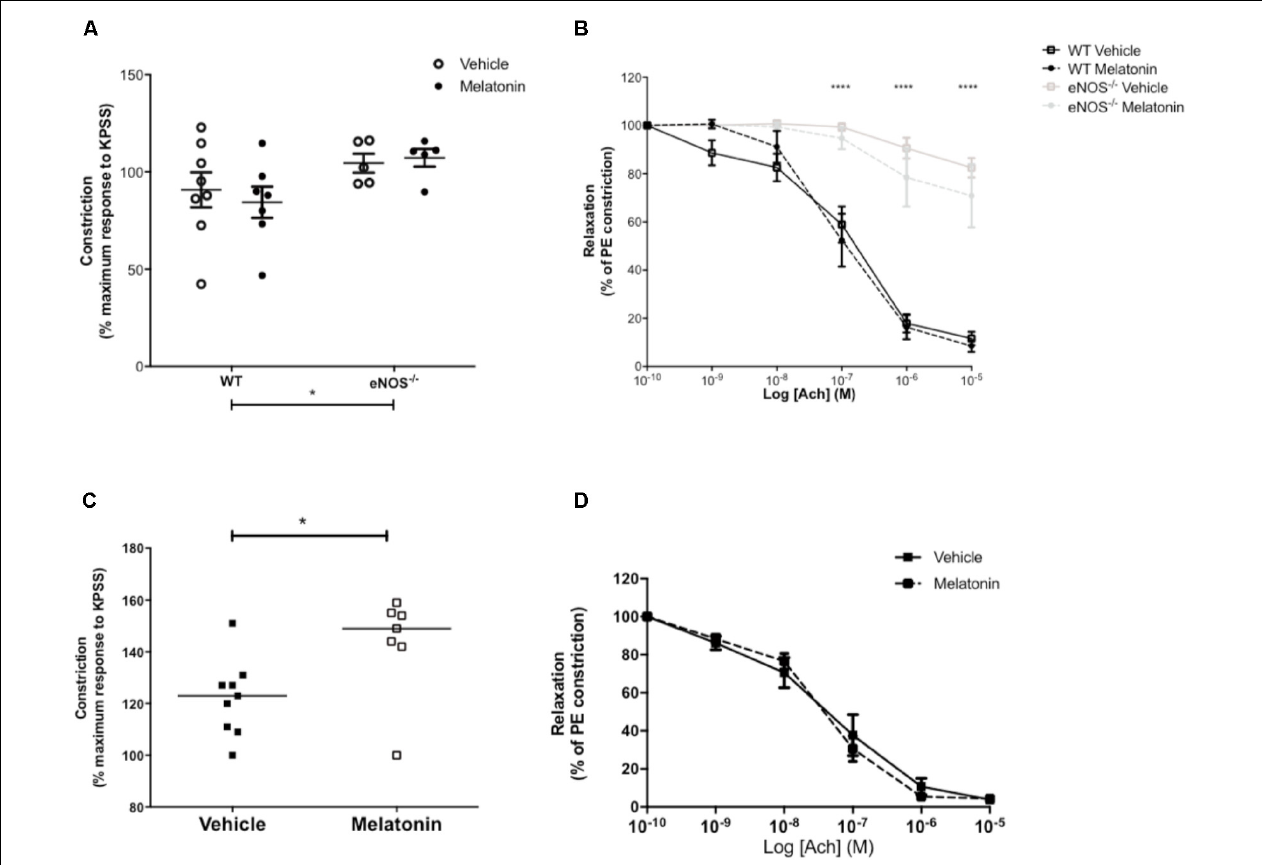
FIGURE 3 | Constriction and relaxation responses of uterine arteries from WT and eNOS - / - mice (A,B) and P0 + / + and P0 + / - mice (C,D) at embryonic day 18.5. (A,C) Constriction to 10 - 5 M phenylephrine shown as a percentage of the KPSS constriction; each dot represents a single animal, line denotes mean. (B,D) Dose dependent relaxation to acetylcholine is shown as a percentage of constriction to phenylephrine. Data are presented as mean ± SEM (A,B,D) or all data points with line denoting median (C) . Number of mice were as follows; WT N = 8, eNOS - / - N = 5, for both vehicle and melatonin groups. For uterine arteries from P0 matings, N = 9 for vehicle and N = 7 for melatonin treated. Statistical analysis in (A,B) was carried out by two-way ANOVA to assess the effect of genotype and treatment with Bonferroni post-test to compare individual groups. In (C) , a Mann–Whitney test was performed and in (D) a two-way ANOVA to assess the effect of treatment and [Ach]. ∗ P < 0.05, ∗∗∗∗ P < 0.0001 for effect of genotype independent of